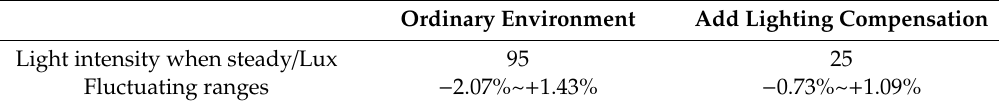
Figure 9. The effect of light compensation on test results. Table 1. Measurement accuracy comparisons with or without illumination compensation.